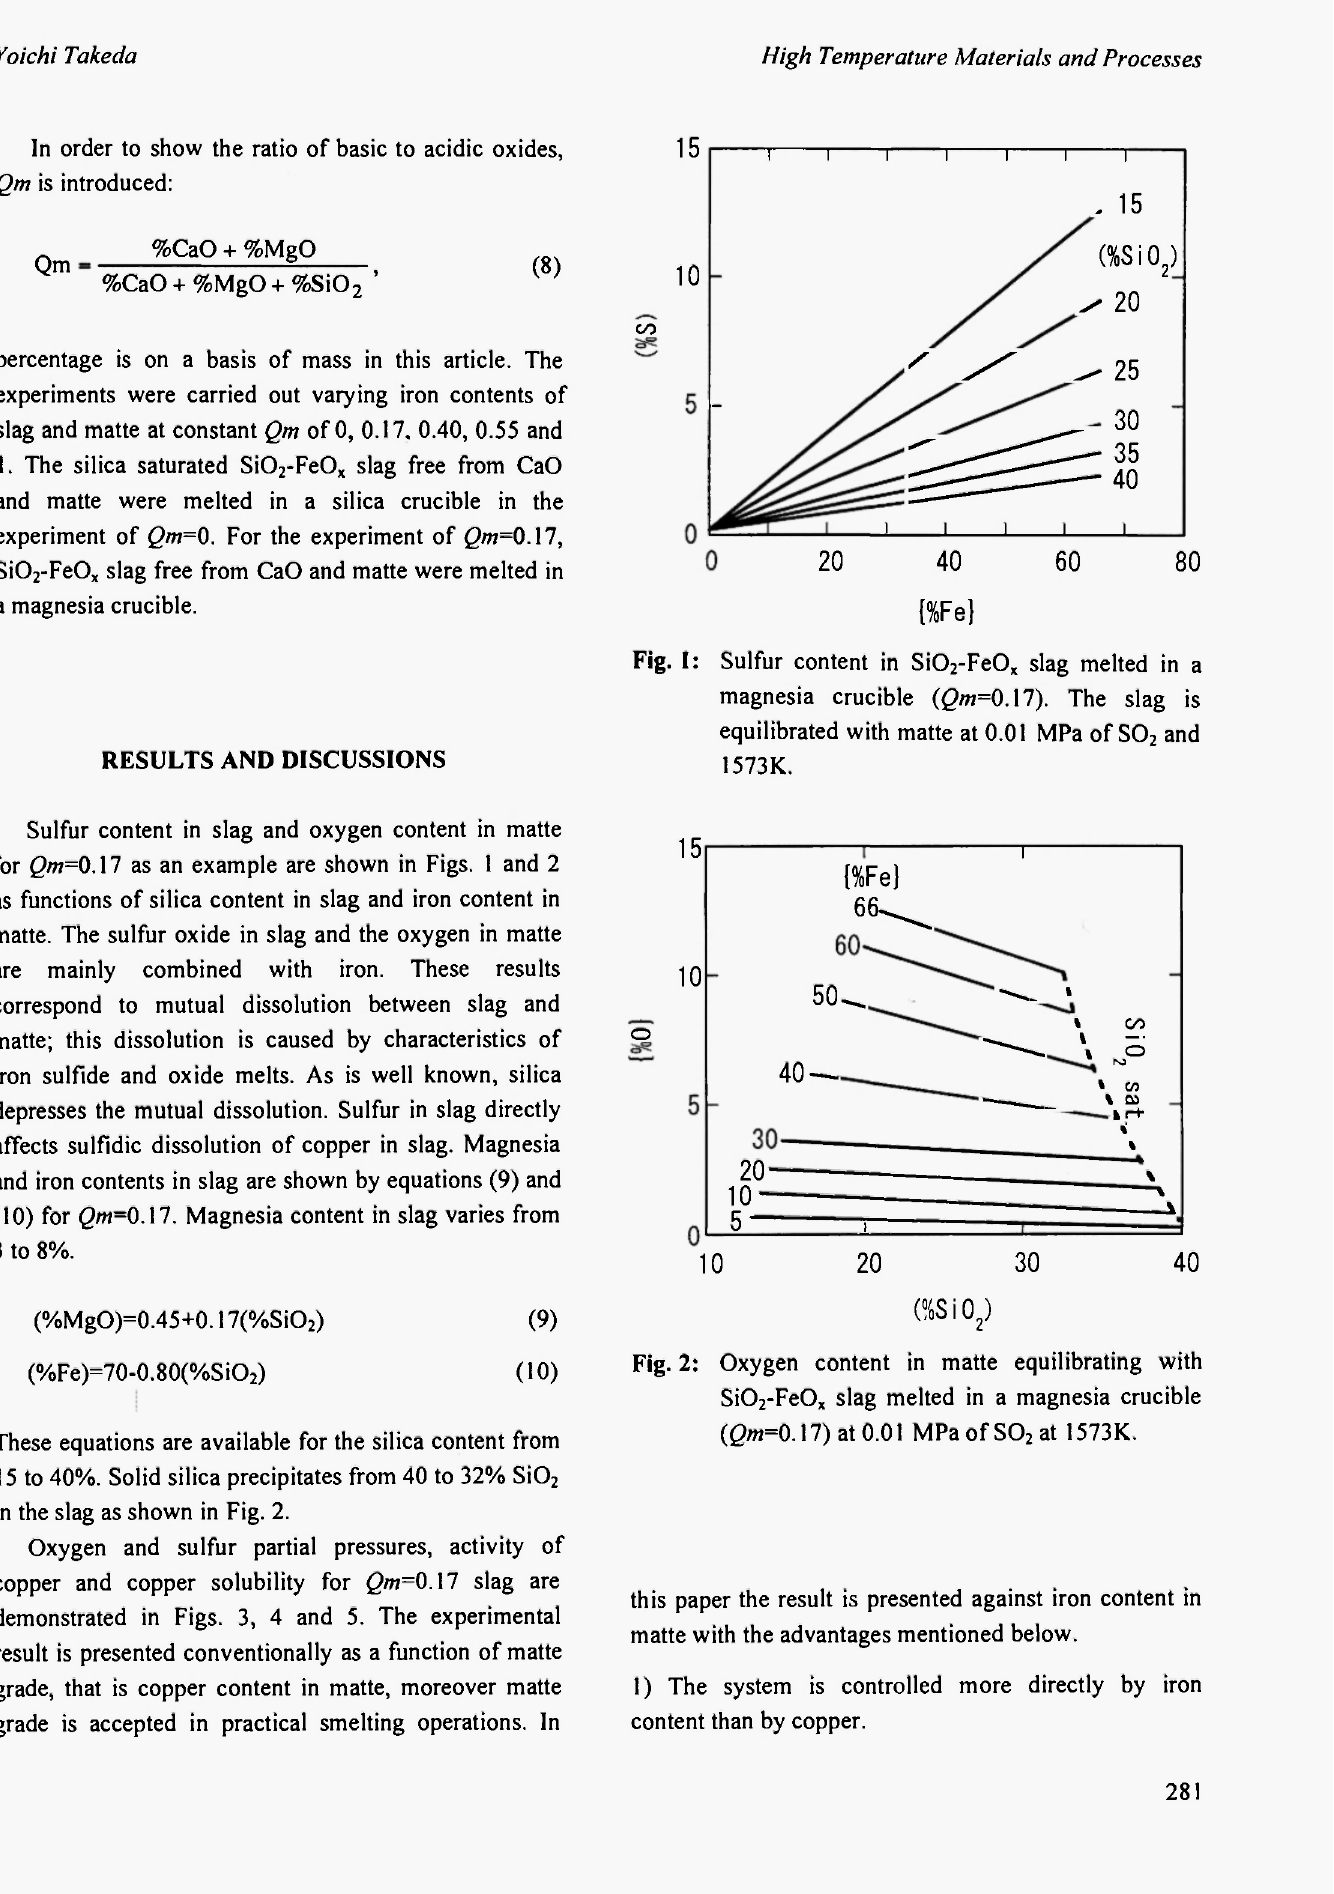
Fig. I: Sulfur content in Si0 2 -Fe0 x slag melted in a magnesia crucible (Qm=QAl). The slag is equilibrated with matte at 0.01 MPa of S0 2 and 1573K.